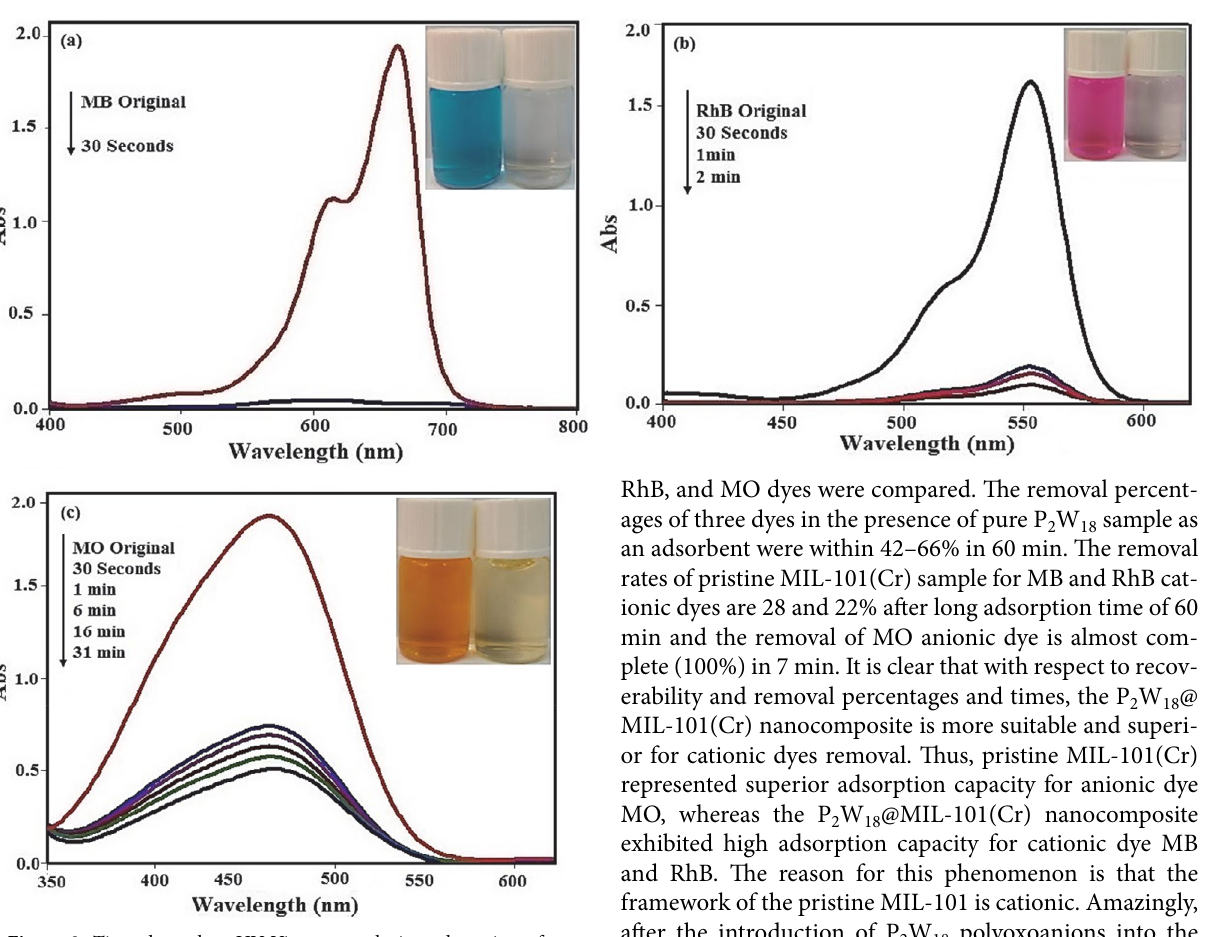
Figure 8. Time dependent UV-Vis spectra during adsorption of dyes over P 2 W 18 @MIL-101: (a) MB, (b) RhB, (c) MO. [dye] 0 = 25 mgL –1 ; 30 mL, adsorbent amount = 30 mg, temp.= 25